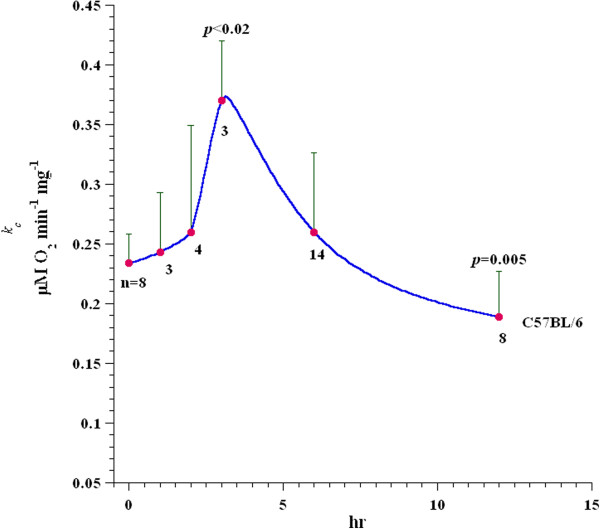
Time-dependent changes in liver respiration in ConA hepatitis in C57Bl/6 mice. C57Bl/6 mice (wild-type) were injected with PBS or 12 mg ConA/kg. Liver tissue specimens were then collected at the indicated timepoints and processed for O2 measurements. Values shown are the mean (± SD), with the values of “n” underneath each timepoint. The p-values at 3 and 12 hr (compared to 0 hr) are also shown; remaining values were insignificant.